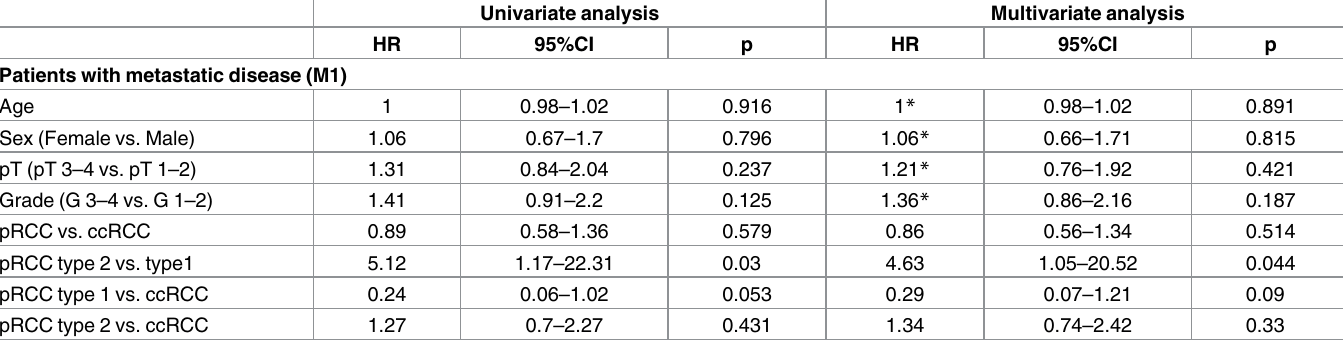
Table 4. Uni- and multivariate Cox cause-specific hazards analysis of pRCC, ccRCC, and pRCC subtypes (type 1 and type 2) and clinical and path- ological variables for the prediction of cancer-specific mortality in patients with metastatic RCC in the post tyrosine kinase inhibitor